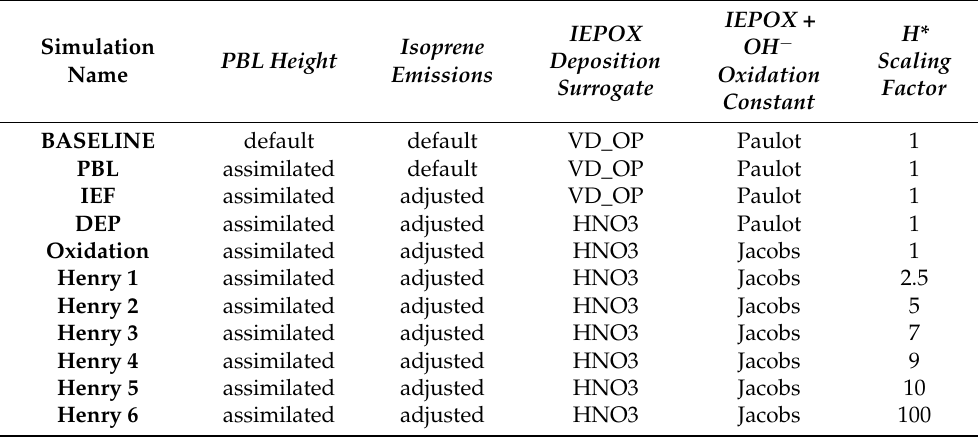
Figure 4. Measured (cyan), default CMAQ (green) and corrected (red) IEPOX diurnal concentrations. The IEPOX corrections data refers to IEPOX levels after updating both the deposition surrogate and the reaction rate constant for the OH − reaction. Measurements from [36]. Table 1. List of simulated scenarios and their specifications. The Henry’s law coefficient H is equal to 2.7 × 10 6 M atm − 1 .